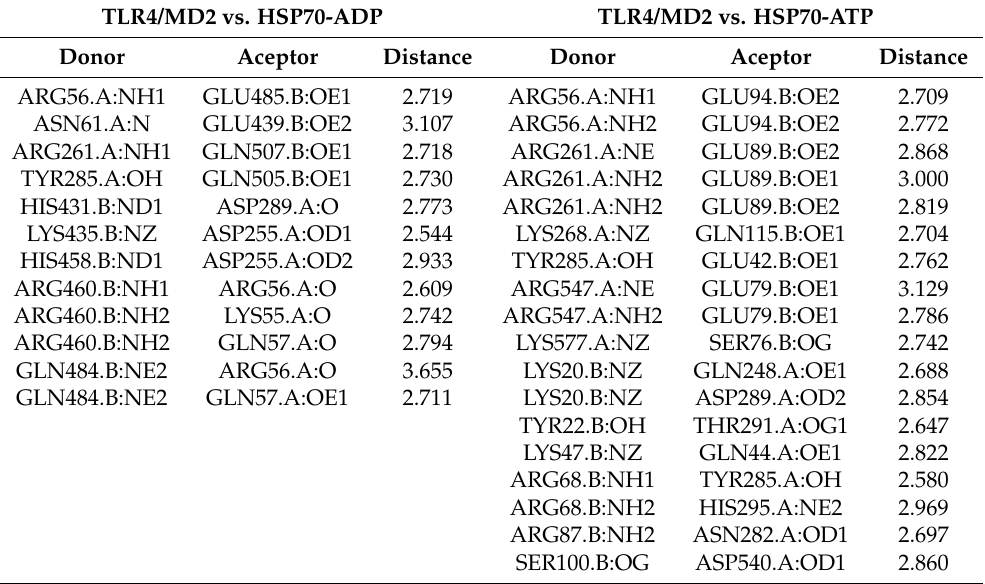
Table 3. Interacting residues and distance (Å) of the top ranked docking conformation generated in the web server ClusPro 2.0. Chain A represents HSP70 in the ADP (ID 2KHO) and ATP (ID 4B9Q) bound states and chain B represents the TLR4/MD2 complex (ID